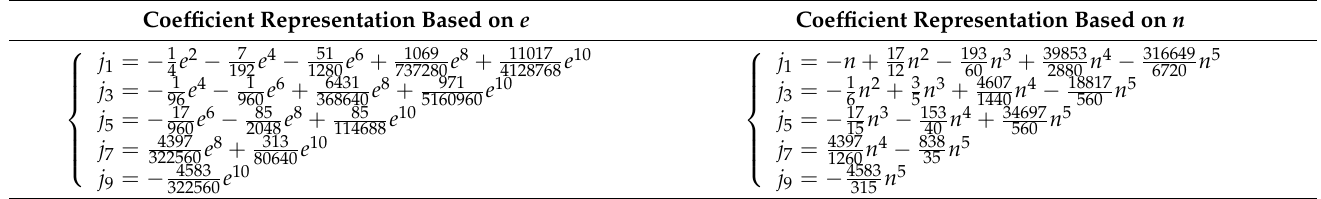
Table 5. Coefficients in Equation (11).